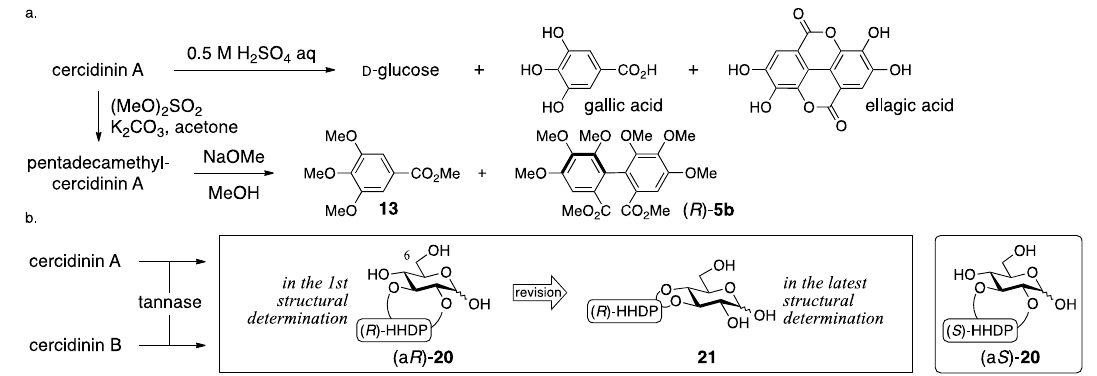
Figure 10. The transformations used in the determination for the first structure of cercidinin A ((a R )- 16 ) and B ((a R )- 17 ).